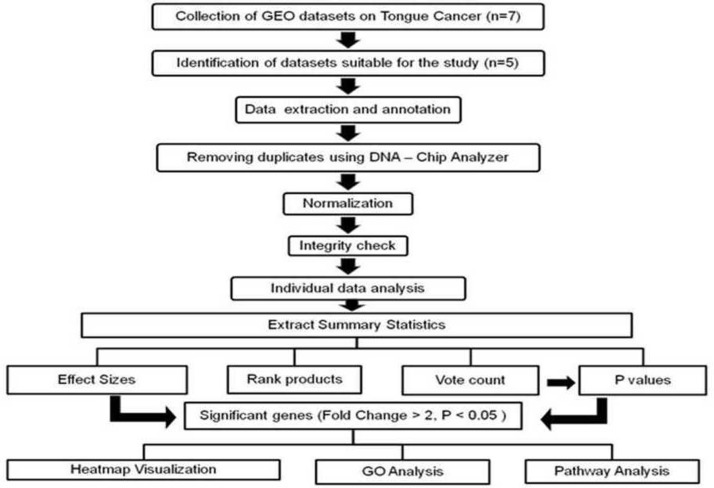
Flow chart representing the meta-analysis study design.